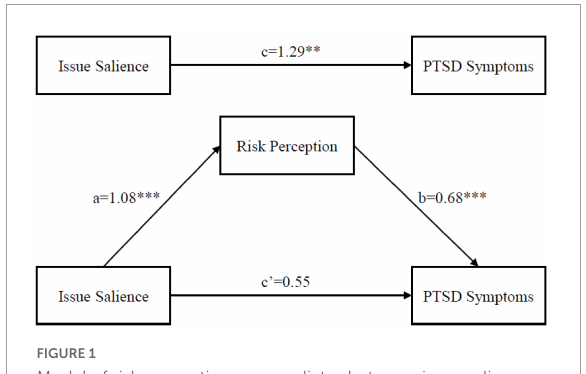
FIGURE1 Model of risk perception as a mediator between issue salience and PTSD symptoms. ** P < 0 . 01, *** P < 0 .